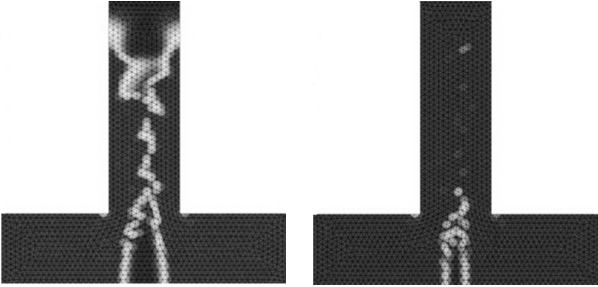
Figure 4. The improved but still untrue results by SUPG (Streamline Upwind Petrov Galerkin) method [9].